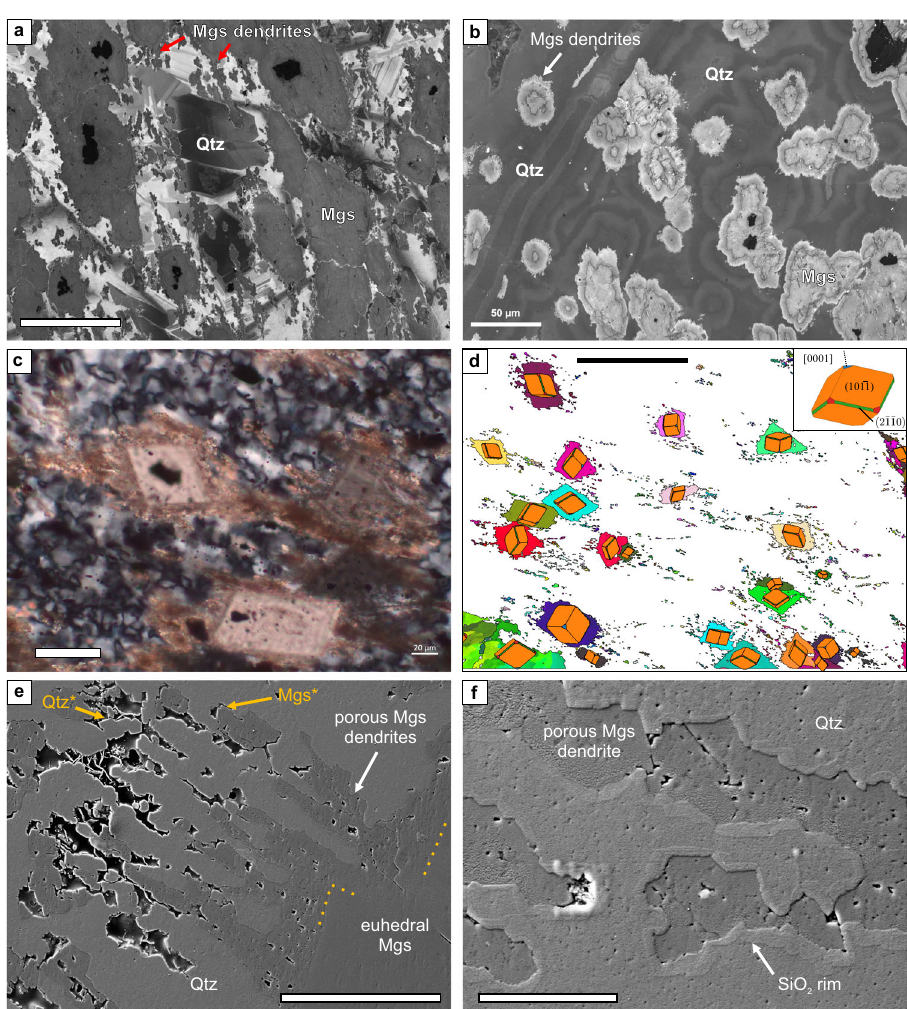
Fig. 7 Crystal growth microstructures in foliated listvenites. a Scanning-electron microscopy cathodoluminescence (SEM-CL) image of magnesite (Mgs) ellipsoids with Fe-magnesite (black) cores and aligned magnesite dendrites, in a quartz (Qtz) matrix with euhedral crystal growth zoning (CL fi lter optimized for quartz). b SEM-CL image of magnesite ellipsoids with concentric zoning and dendritic rims, and concentric spherulitic to botryoidal growth zoning of quartz (CL fi lter optimized for magnesite). c Euhedral magnesite with Fe-oxide inclusions and dendritic rims; quartz in the matrix has a crystallographic preferred orientation (c.f. Fig. 4c) (crossed polarized light image). d Electron backscatter diffraction (EBSD) orientation map of magnesite (color scale see Fig. 4) with corresponding crystal shapes overlay of rhombohedral magnesite (crystallographic axes see inset). e Secondary electron (SE) image of dendritic rim on euhedral magnesite. Sub-micron scale crystal facets of quartz (Qtz*) and magnesite (Mgs*) are visible in the related porosity. f High resolution SE image of a nano-porous magnesite dendrite showing a 100 − 400nm wide SiO 2 rim at the contact to quartz. (a, b: sample